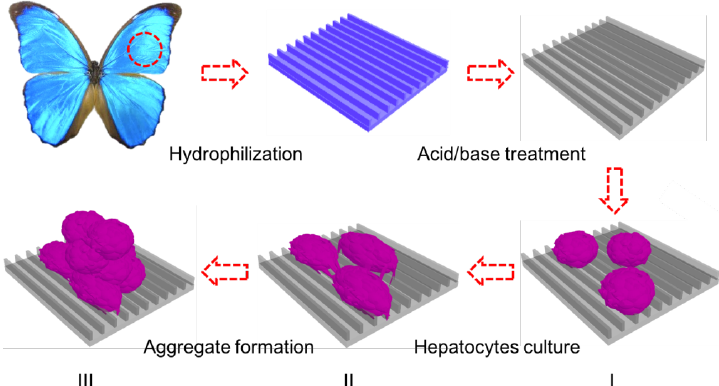
Figure 1. Schematic illustration of the in vitro three-dimensional (3D) model for hepatic culture and hepatocyte aggregate formation. Butterfly wings are chemically treated to turn them hydrophilic prior to HepG2 cell culture. (I) Fresh rat hepatocytes are dispersed onto treated butterfly wings; (II) Single hepatocytes begin migration and adhere together to form clusters; (III) Aggregate formation with extensive cell–cell communication and tight junctions.